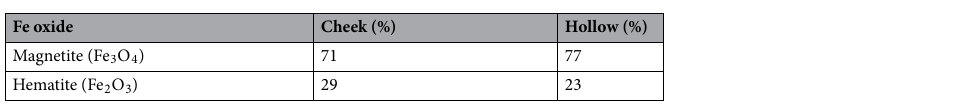
Table 4. Relative amount of Fe oxides in the two regions, calculated through LCF analysis of the XANES data. Uncertainties are ±5%.